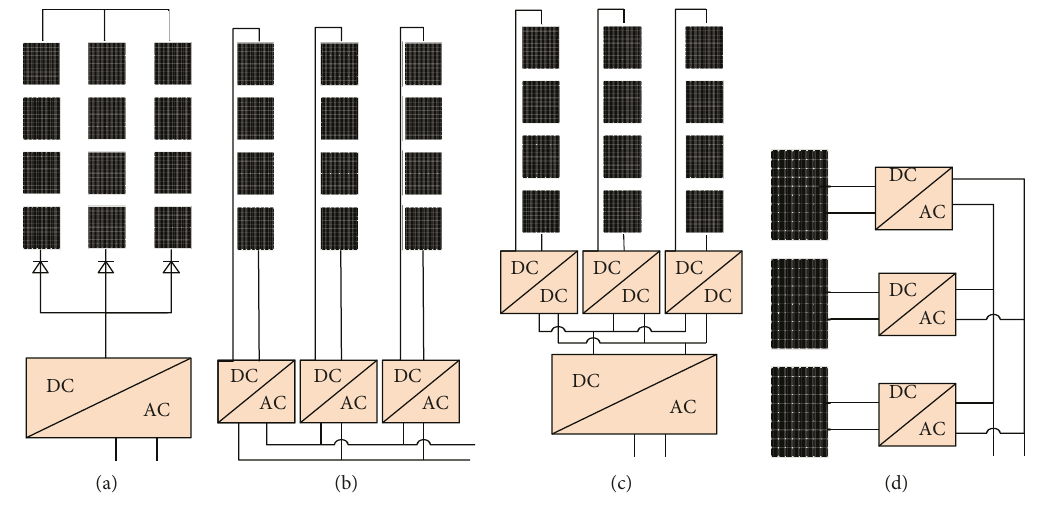
Figure 1: Grid-connected PV system